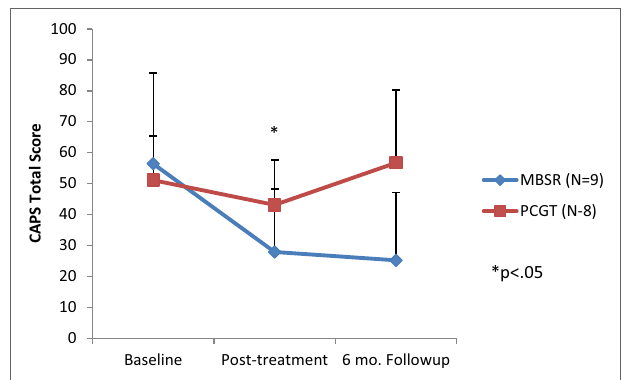
FigUre 1 | Effects of 8 weeks of mindfulness-based stress reduction (MBSR), or present-centered group therapy (PCGT) on symptoms of post-traumatic stress disorder (PTSD) as measured with the Clinician- Administered PTSD Scale (CAPS). There was a significant reduction in PTSD symptoms immediately posttreatment in the MBSR group ( p < 0.05), but not in the PCGT group. These effects persisted at the 6-month follow-up